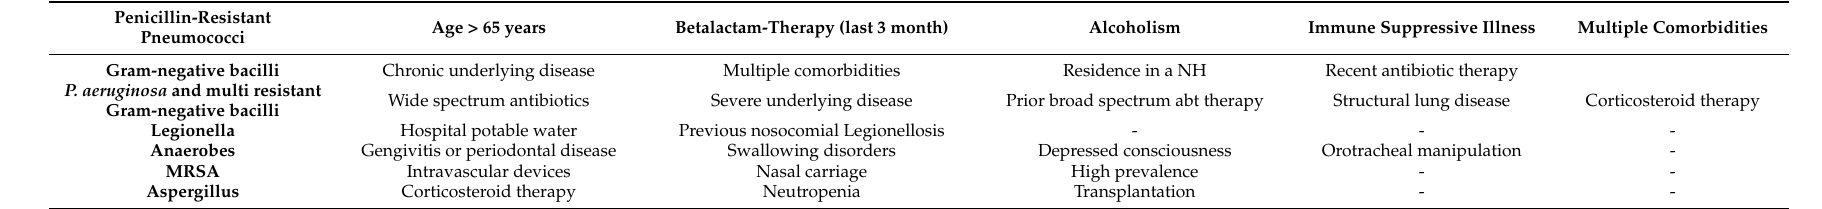
Table 2. Risk factors of infection with specific